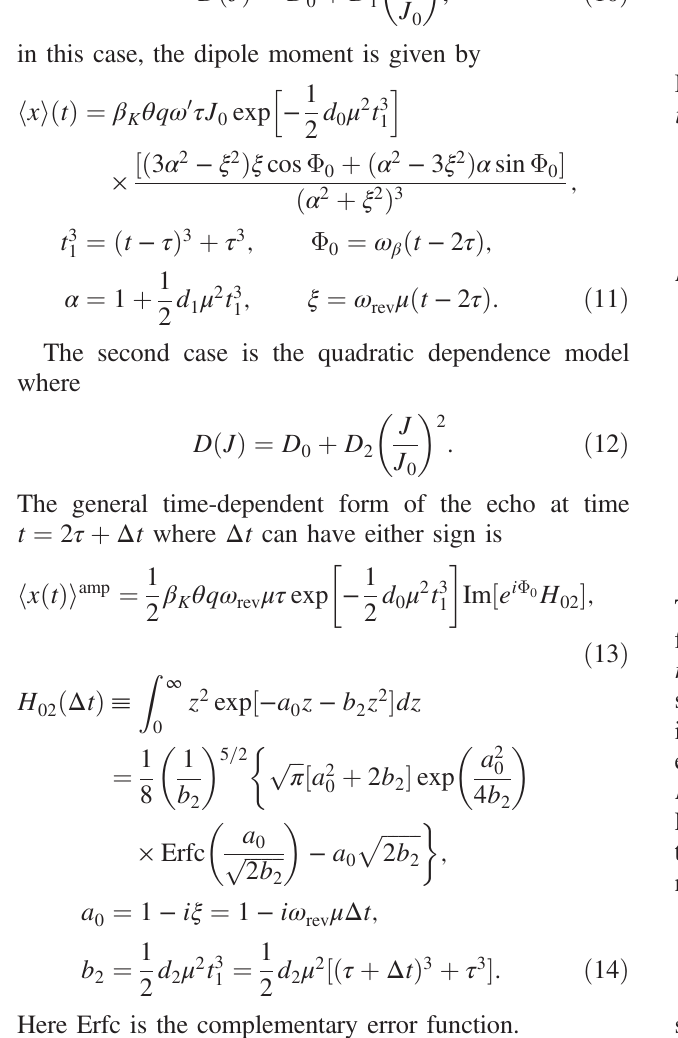
FIG. 1. Left: The echo amplitude as a function of the coefficients D 0 , D 1 , and D 2 scaled by the value D Right: Form of the echo pulse with the D 1 , D 2 model shown in blue. The red curve outlines the upper envelope of the echo. Beam parameters in both plots were taken from Table I, except for μ ¼ 0 . 0077 . D 1 and D 2 in the right plot were set to the values D 1 ;sc and D 2 ;sc , respectively, which are defined in Sec. III